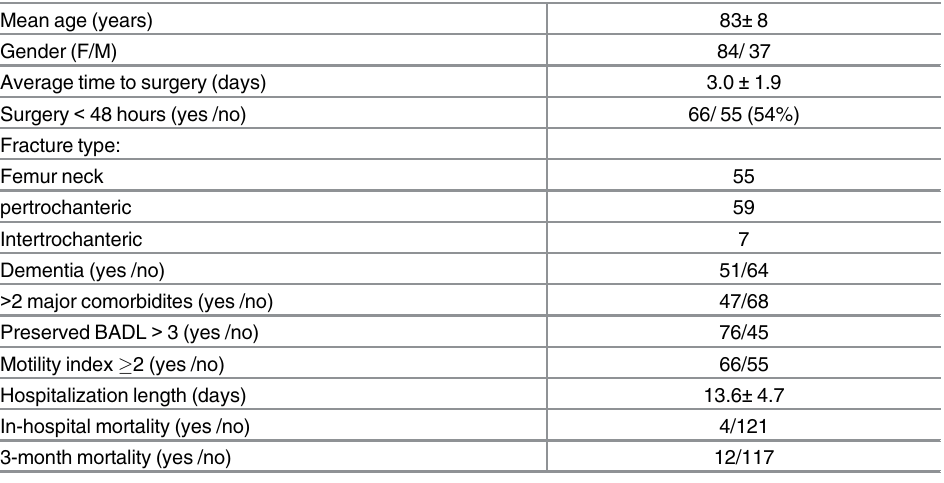
consecutive patients admitted between January and June 2011 recalled by administrative rec- ords. Only 26% of these patients were treated within 48 hours (p < 0.0001 vs. the intervention cohort, Table 3).